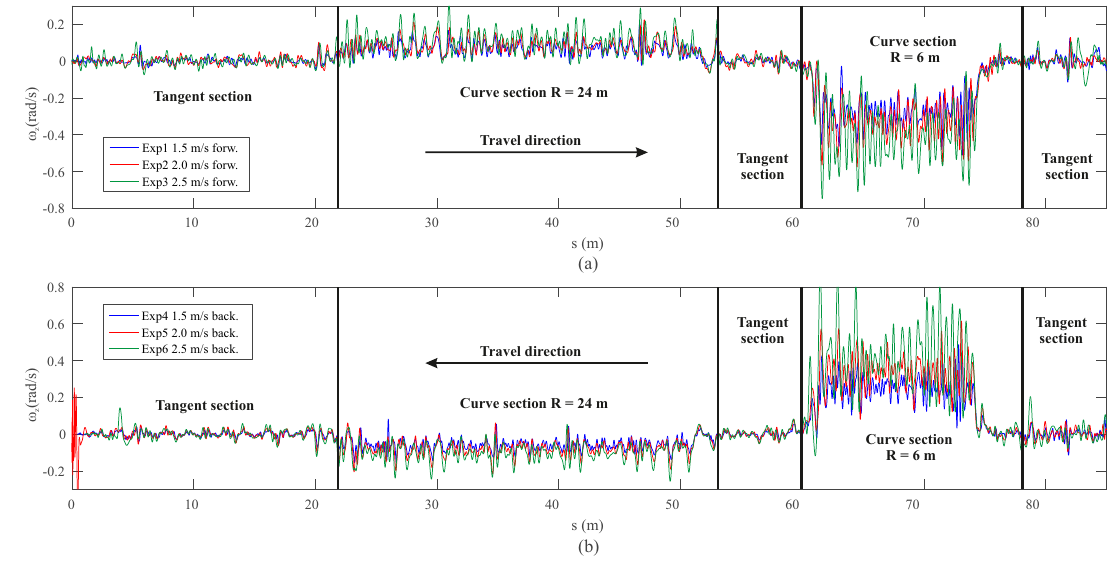
Figure 10. Measured yaw angular velocity of the leading axle in the forward ( a ) and backwards experiments ( b ).